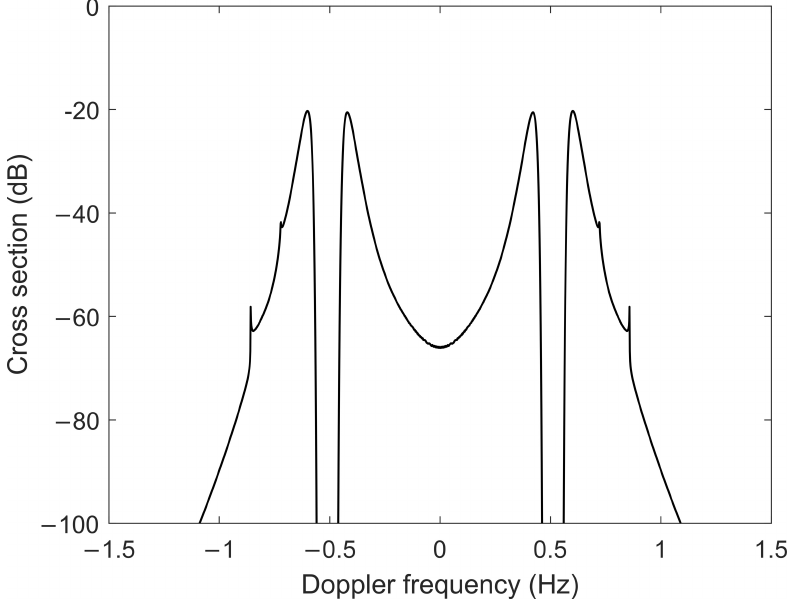
Figure 3. Second-order cross section for FMICW source with a operating frequency of 25